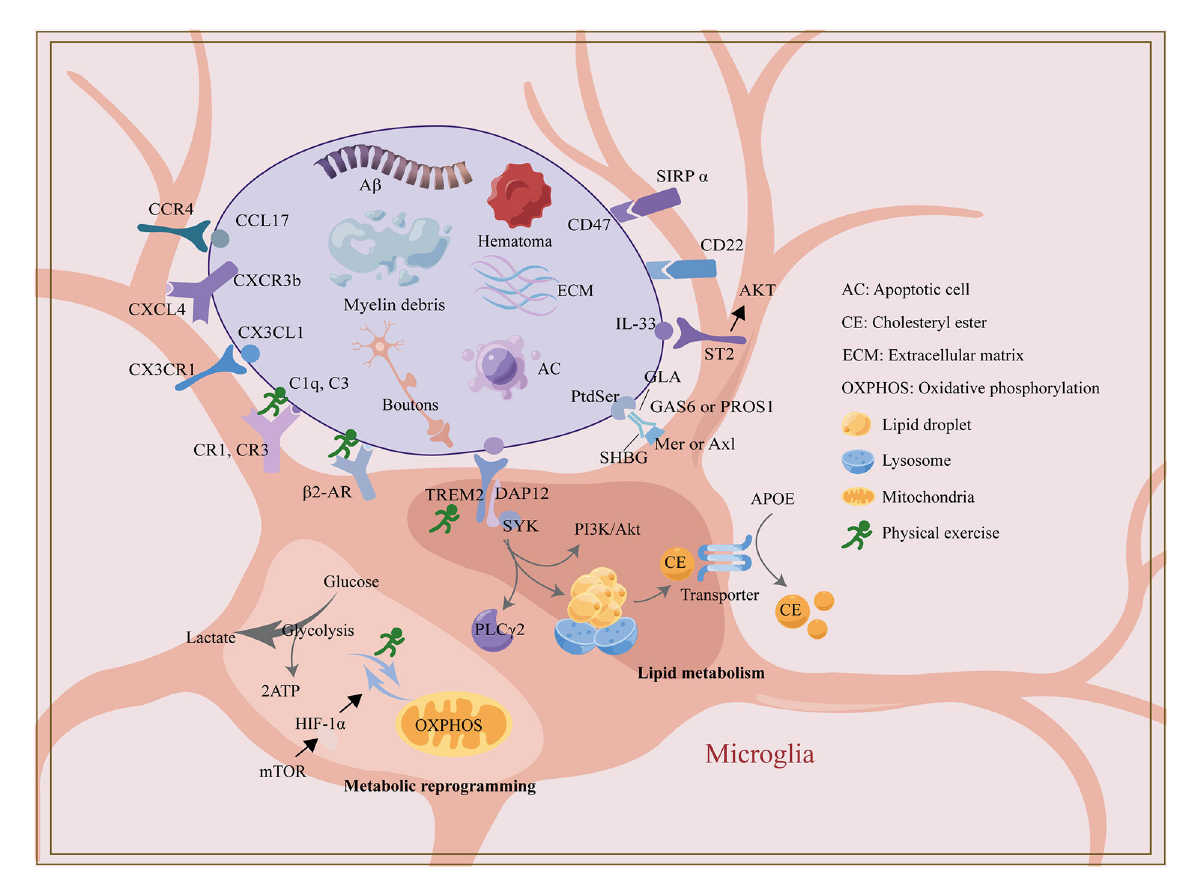
FIGURE1 The regulatory mechanism of microglia phagocytosis and